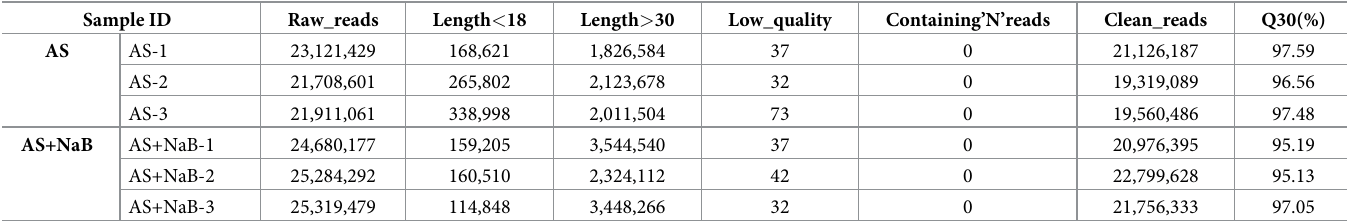
Table 1. Statistics on miRNAs sequencing